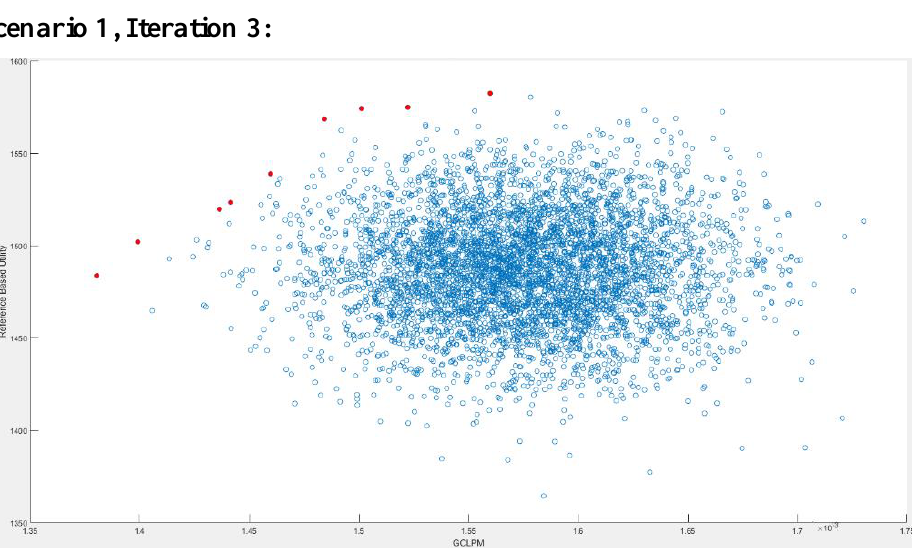
Figure 5. The Result Of Investigation Of 5,000 Different Portfolios In Third Iteration Of Scenario 1